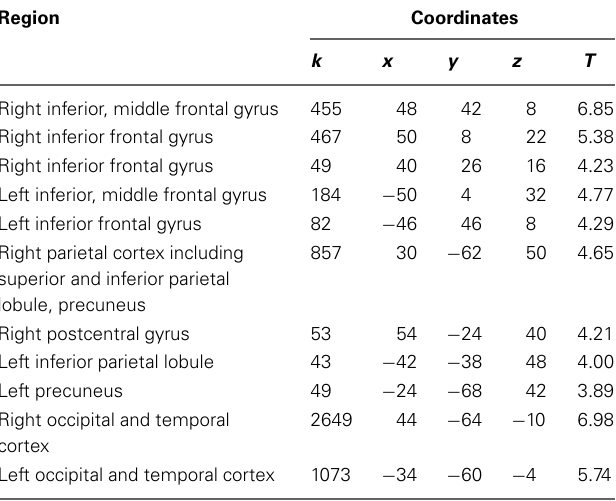
Table 1 | Coordinates and peak activation statistics for clusters in